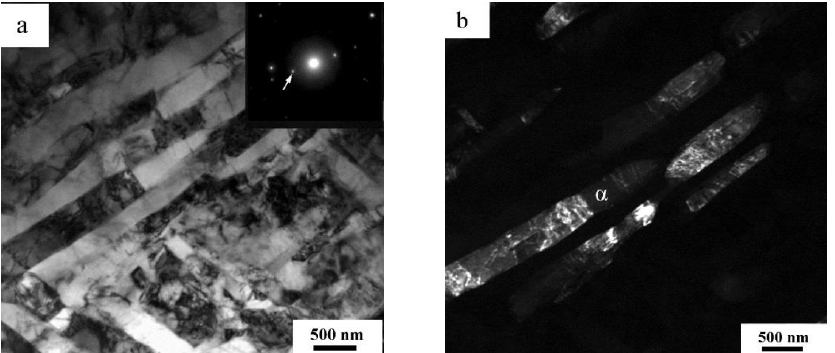
Figure 1. SEM images of electron beam melting (EBM) Ti-6Al-4V alloys: as-built samples ( а ), after pulsed ion beam (PIB) exposure (mode 1) ( b ), after PIB exposure (mode 2) ( c ).